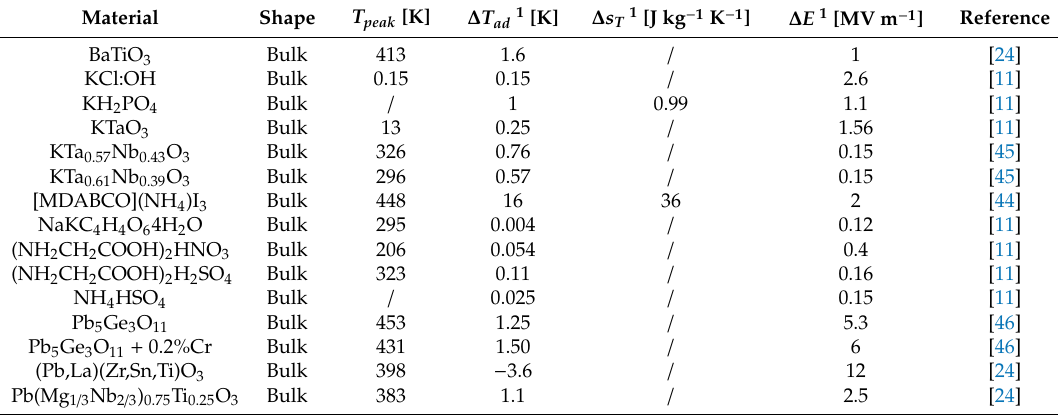
Table 1. Monocrystals materials and their electrocaloric